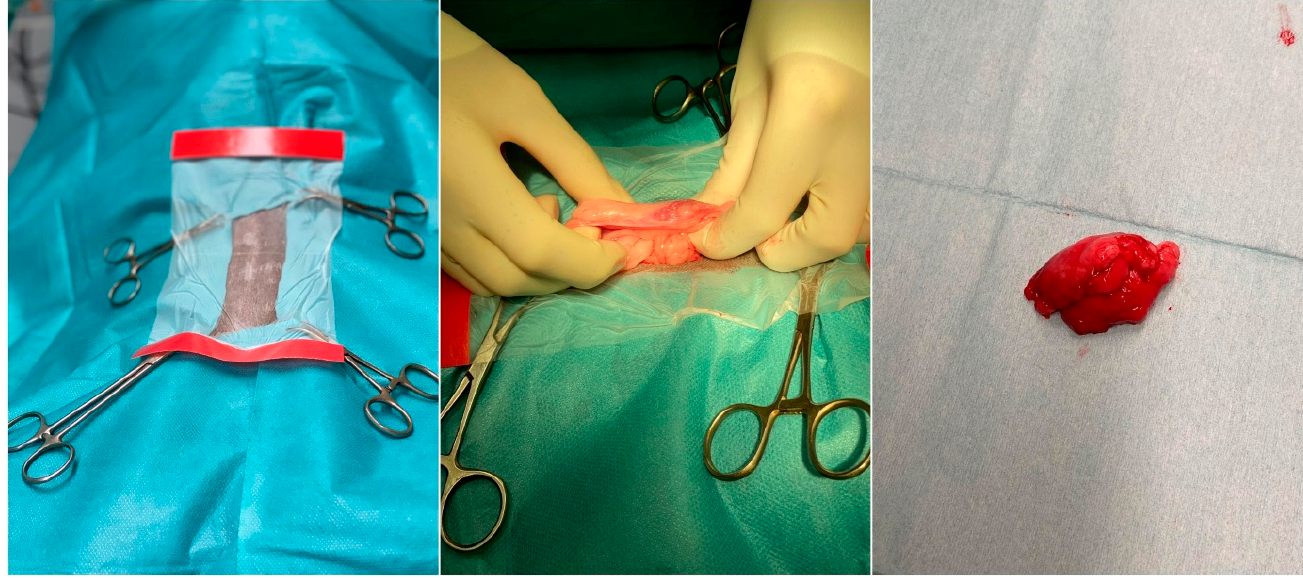
Figure 1. Adipose tissue collection during canine ovariotomy. The routine procedure commonly performed in young females presents an excellent opportunity to collect adipose tissue and store cells for future use in regenerative therapy.